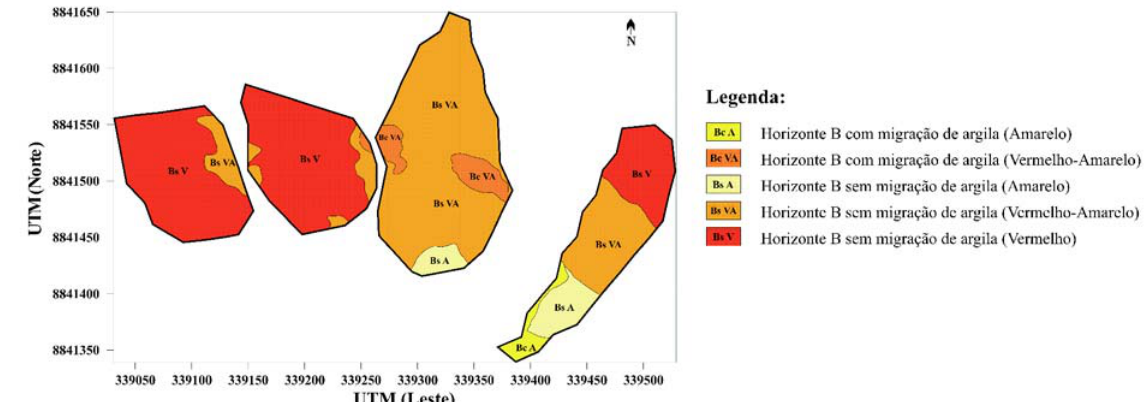
Figura 6. Mapa gerado por meio da sobreposição dos mapas da relação textural (RT) e índice de avermelhamento